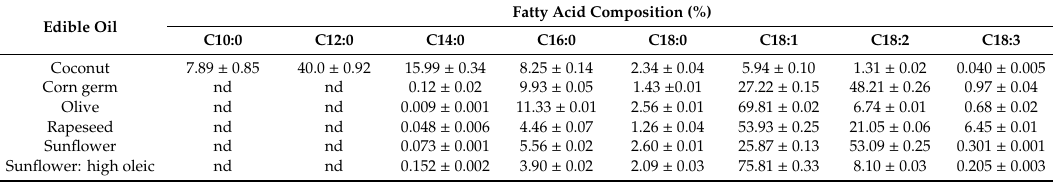
Table A1. Fatty acid composition of edible oils (%) and their inherent